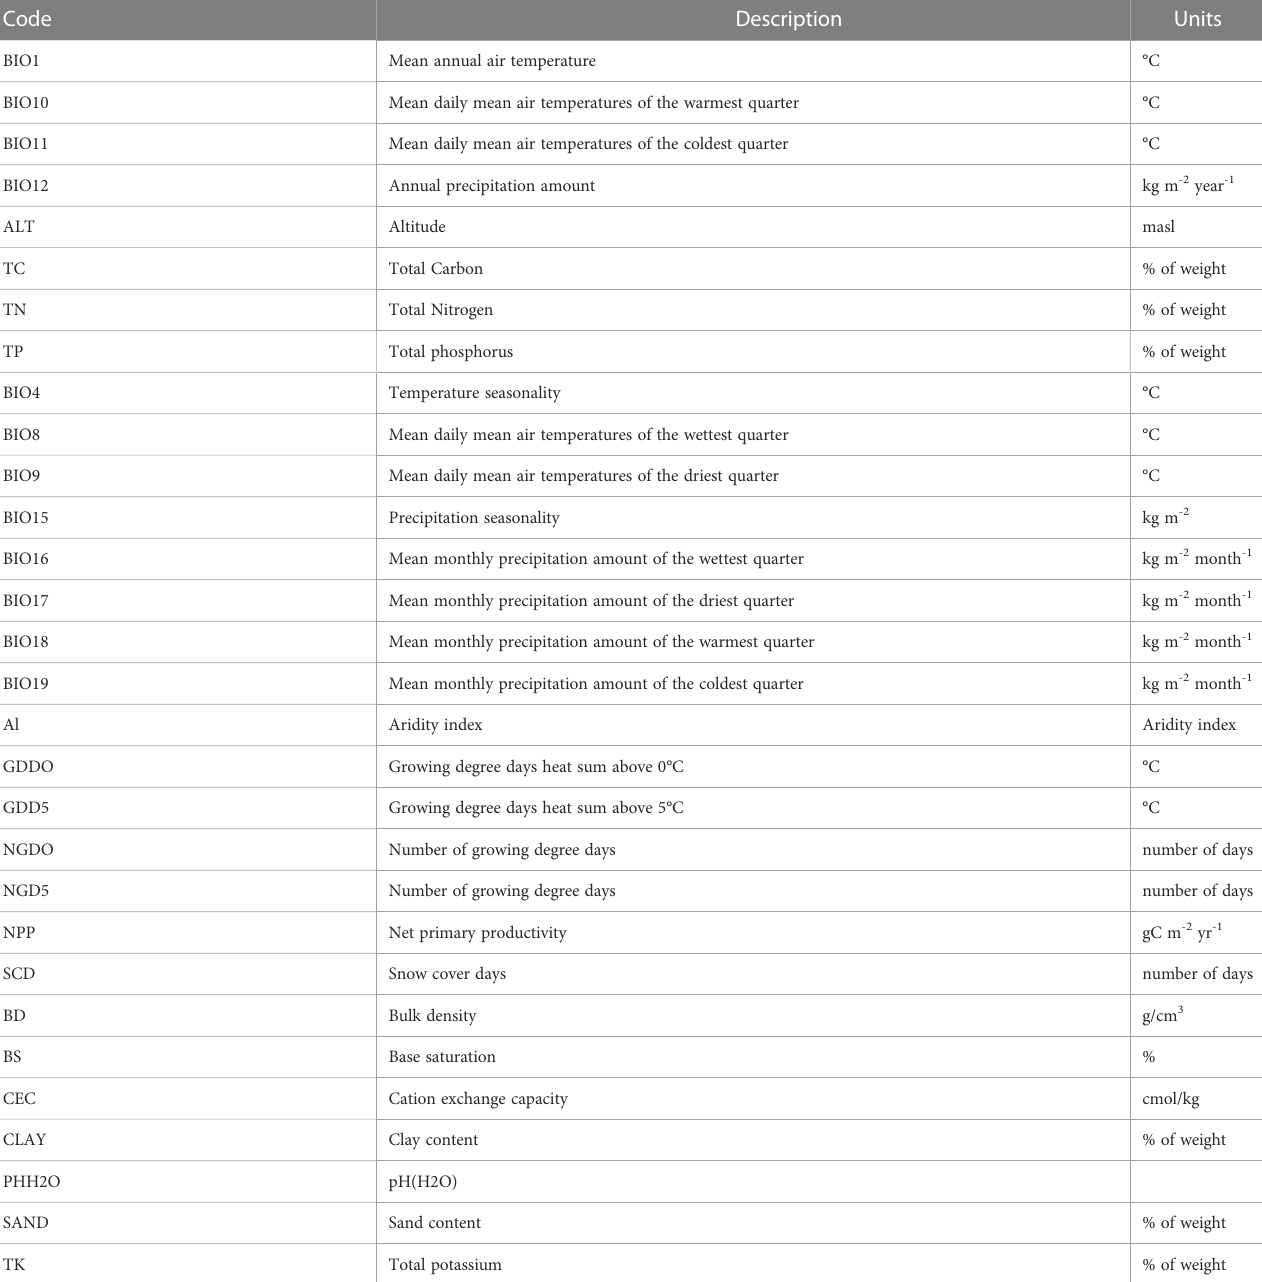
TABLE 1 Original variables used in the